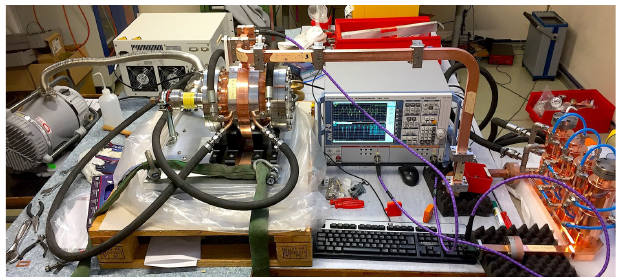
FIG. 5. Measurements of the pulse compression system.